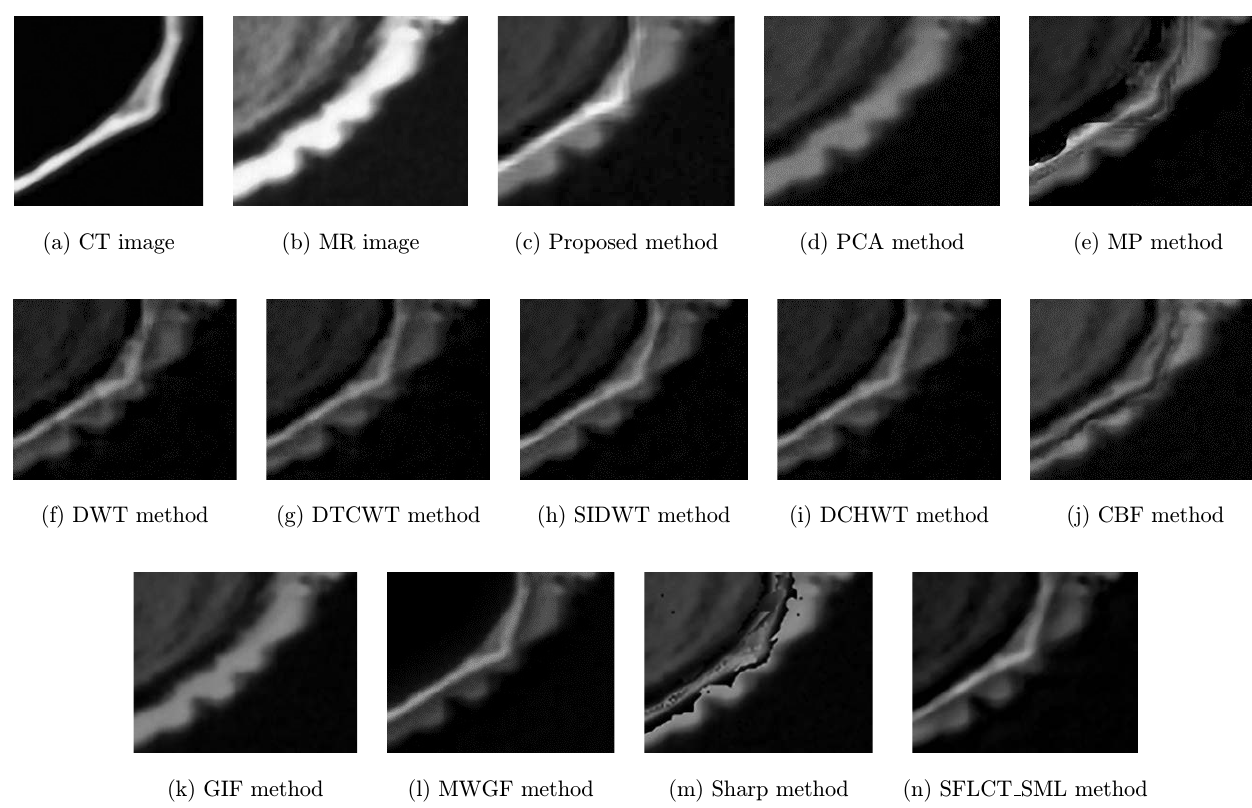
Fig. 4. Partial enlarged regions from fused images of the ¯rst group of medical